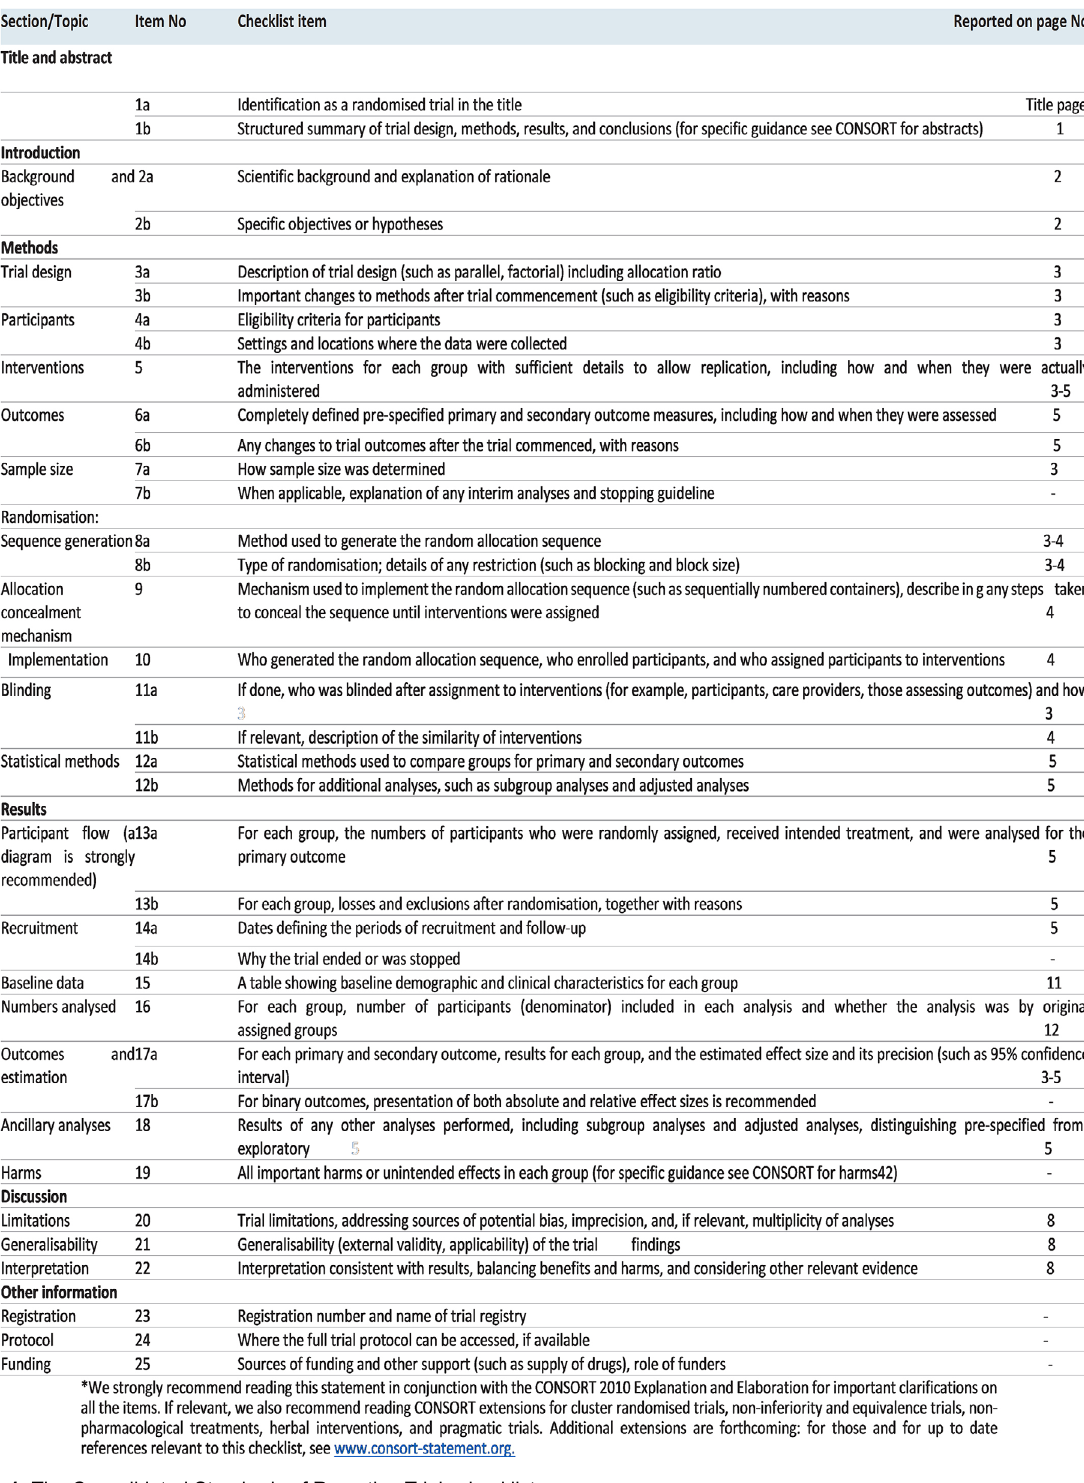
Figure 1- The Consolidated Standards of Reporting Trials